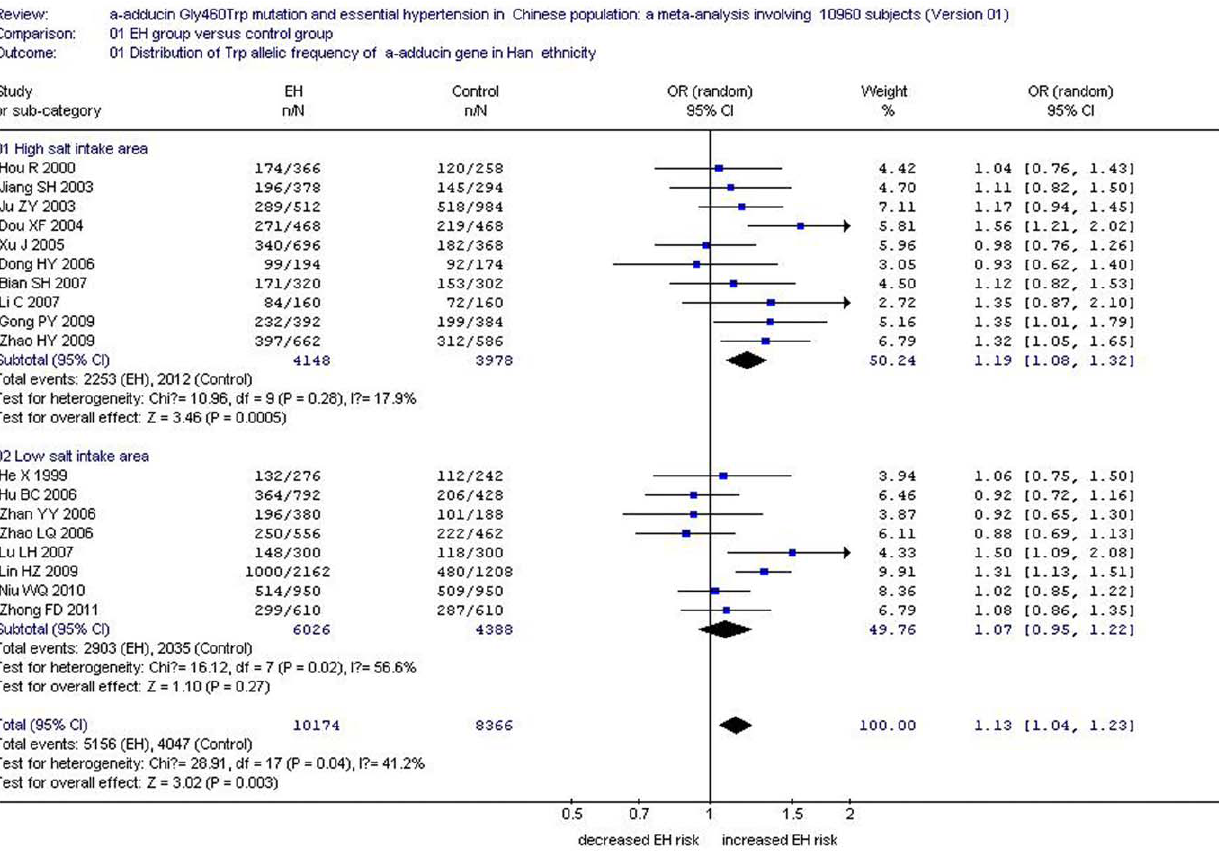
Figure 5. Forest plot of essential hypertension associated with a -adducin Gly460Trp gene polymorphism under an allelic genetic model (distribution of Trp allelic frequency of a -adducin gene) stratified by salt intake area in Chinese Han population.